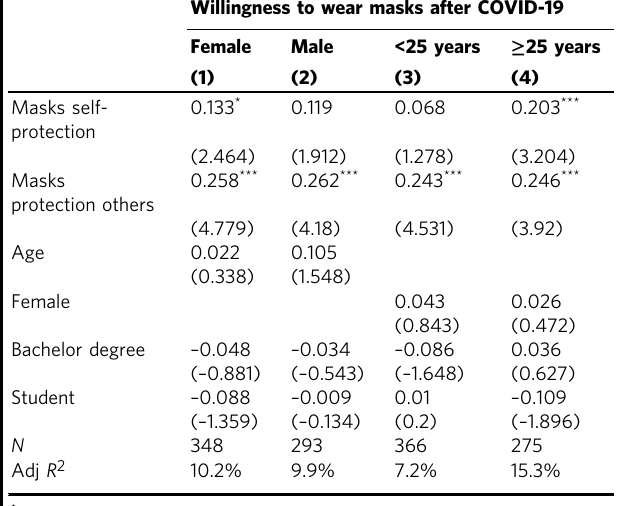
Table 2 Willingness to wear masks after COVID-19, controlling for perceived protection from mask wearing.